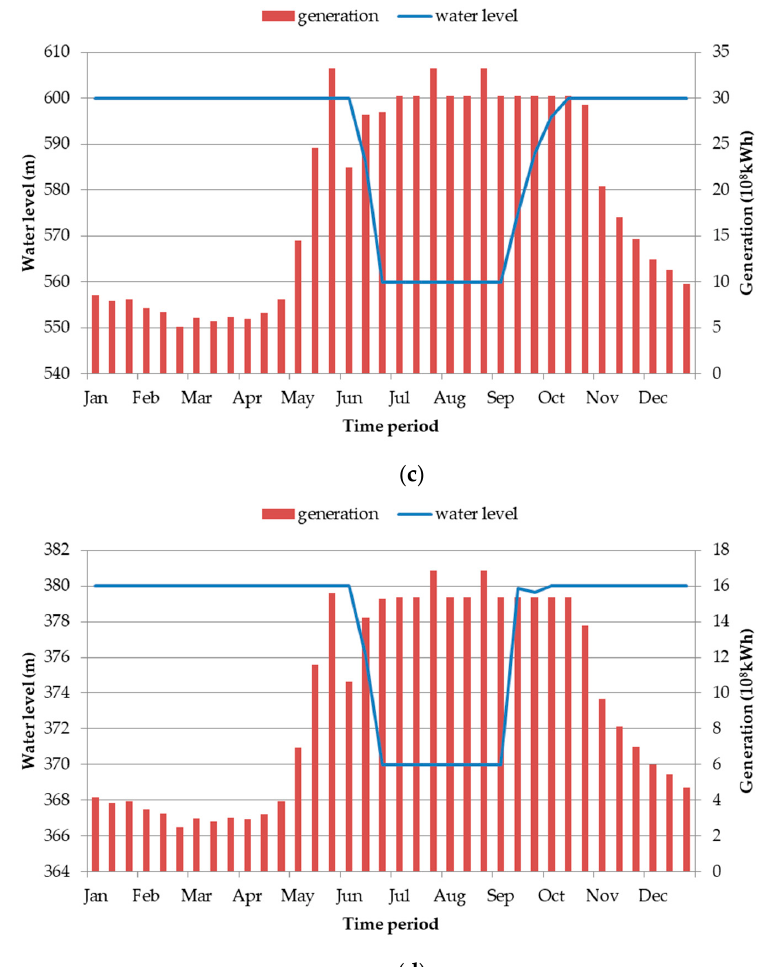
Figure 7. The optimal results obtained by GSA in wet years: ( a ) Wudongde; ( b ) Baihetan; ( c ) Xiluodu; and ( d ) Xiangjiaba.